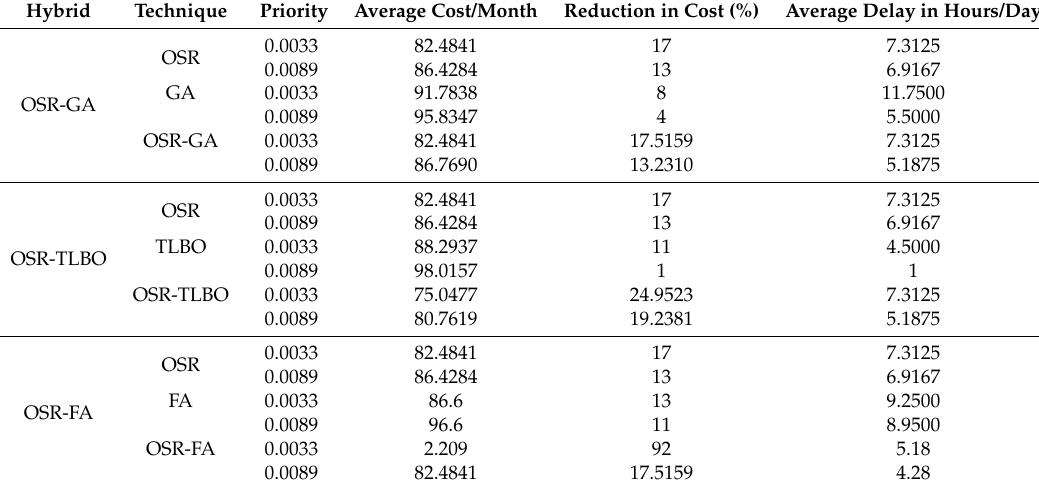
Table 8. Refrigerator Simulation Statistics.